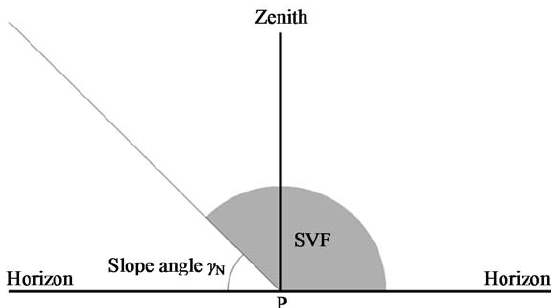
Figure 1. Approximation of the sky view factor (SVF) at P in the r.sun model.